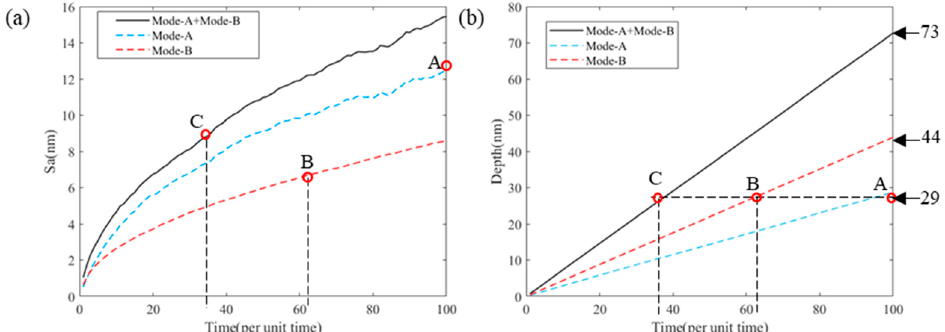
Figure 18. Surface roughness (Sa) and removal depth change with the number of iterations: ( a ) the influence of different modes on the surface roughness and ( b ) the influence of different modes on removal depth.